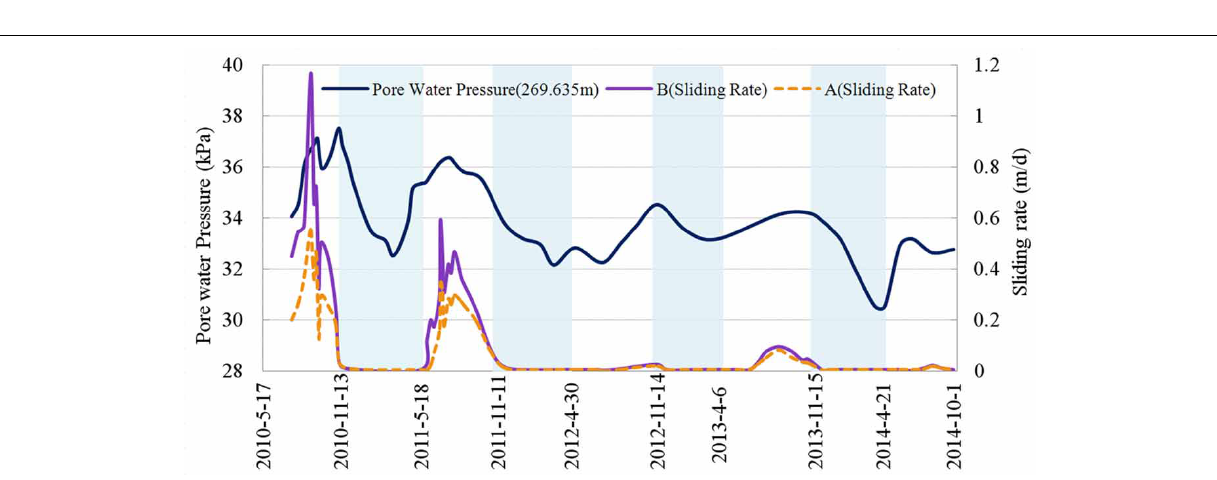
FIGURE 13 | Horizontal displacement rates at point A and point B on the landslide mass and pore water pressure at point D (19.4m depth) in K178 + 530 section of Bei’an-Heihe